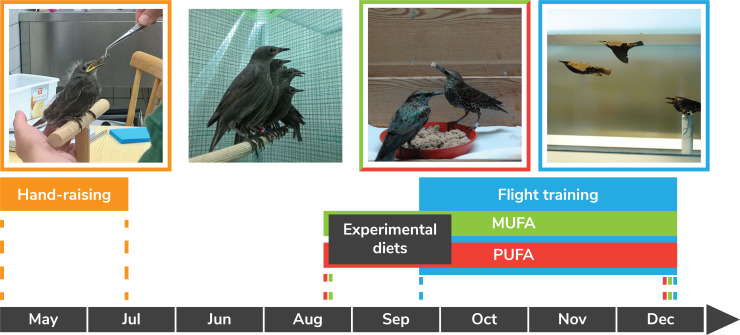
Experimental design for both Experiments I and II from hand-raising of nestling European starlings, to acclimation to one of two experimental diets (both composed of 42% carbohydrates, 23% protein, and 20% fat but differing in the amount of polyunsaturated (PUFA) or monounsaturated (MUFA) fatty acids), and then to flight training in a windtunnel.During fall, cohort groups of 2–3 starlings were flight trained in the windtunnel for 14 days and then flew on Day 15 a long-duration (usually 6 hr) flight (see Figure 5) during which energy expenditure and plasma indicators of metabolism and oxidative status were measured. For Experiment I, we flight-trained 36 starlings of which 33 completed their 6 hr long-duration flight (16 fed the MUFA diet, 17 fed the PUFA diet). For Experiment II, we added 1–2 untrained, sedentary (control) starlings in each training cohort which resulted in a total of 19 MUFA-fed birds (11 flight-trained, eight sedentary) and 17 PUFA-fed birds (nine flight-trained, eight sedentary).